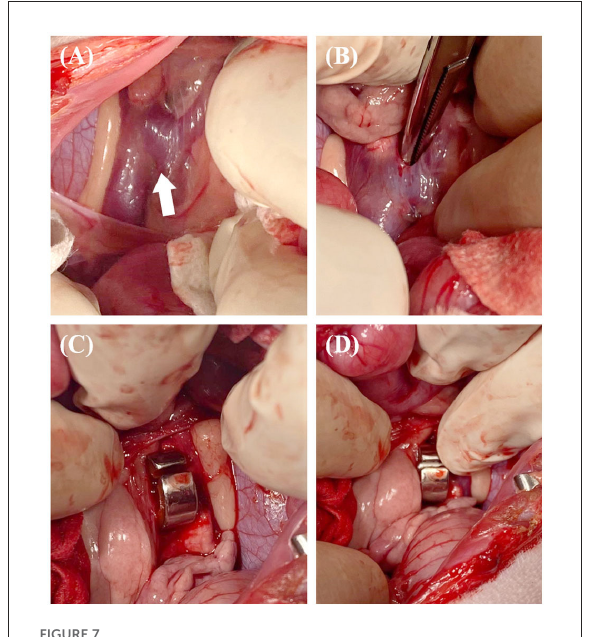
FIGURE7 The surgical procedure for case 2. Approach between the kidneys to secure visibility around the shunt (white arrow) (A) . The dissection performed was sufficient to place an ameroid constrictor (B) . The constrictor was placed around the shunt (C,D)